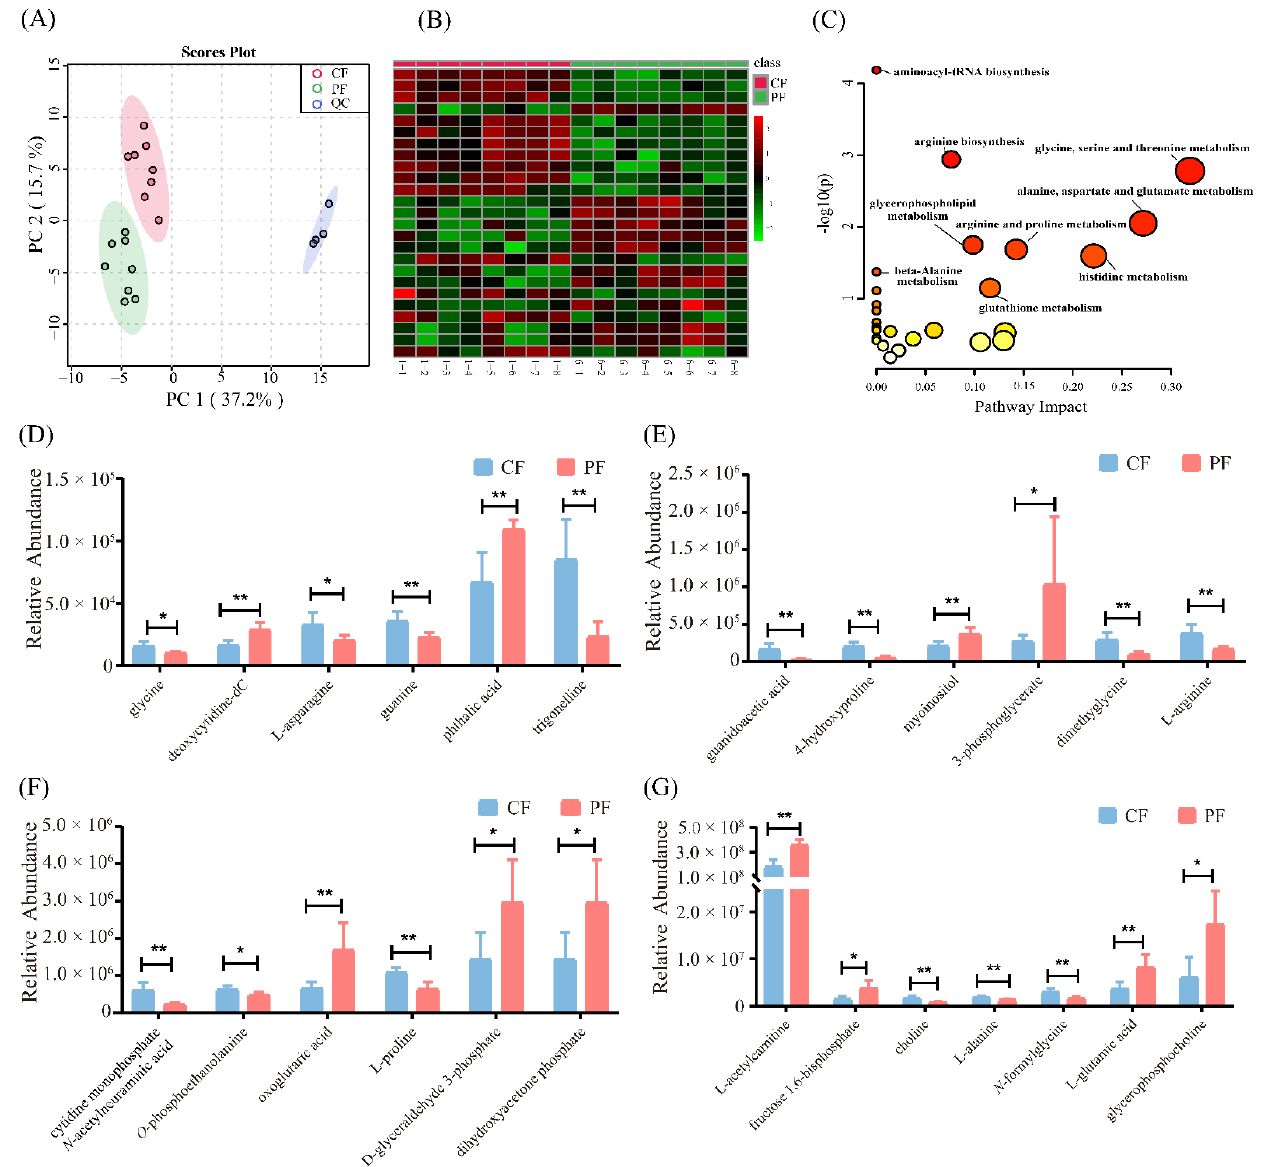
Figure 3. Hydrophilic metabolites in concentrate-fed (CF) and pasture-fed (PF) groups ( n = 8). ( A ) Score plots of principal component analysis of the identified metabolites. ( B ) Heatmap and ( D – G ) bar graphs present the significant metabolites between the CF and PF groups. The significantly increased and decreased levels of metabolites were represented as the red and green cells, respectively, in the heatmap. ( C ) Pathway analysis of significantly different metabolites by means of MetaboAnalyst 5.0 online. QC, quality control samples. * p < 0.05, ** p < 0.01.